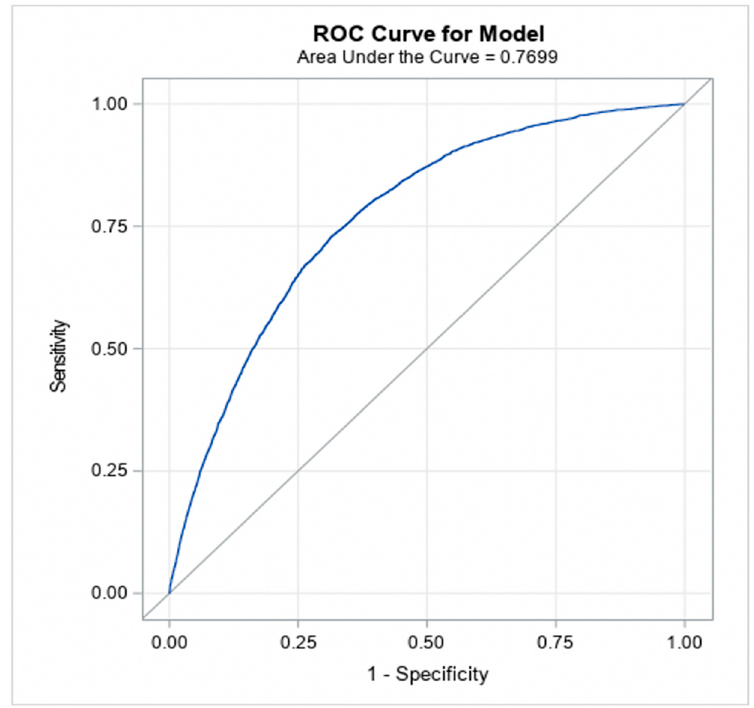
Figure 2. Discrimination ability of the model (to classify patients into moderate/severe AS versus no AS).